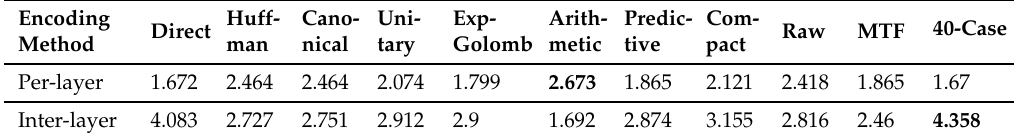
Table 2. Comparison of average compression ratios (Equation (5)) for 10 lossless MAT-encoding methods on 100 images using only per-layer compression (top row) and inter-layer compression (bottom